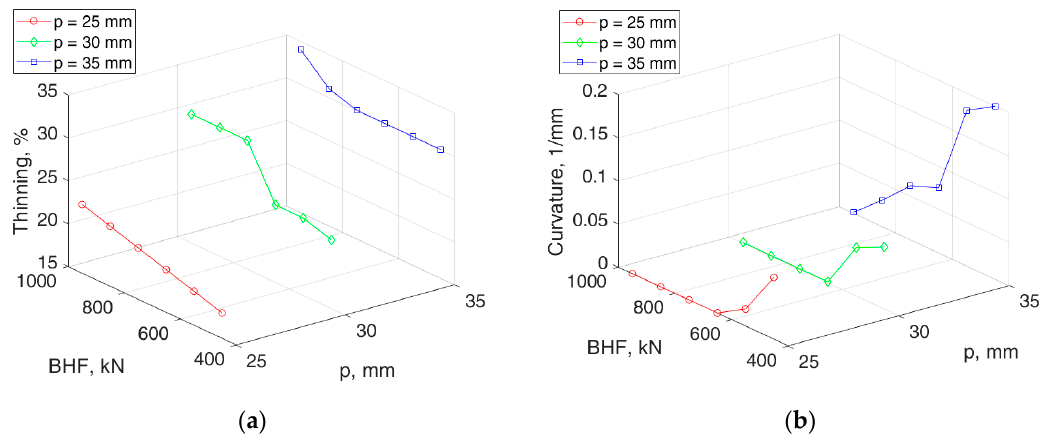
Figure 10. Influence of BHF and p on ( a ) thinning and ( b ) curvature.